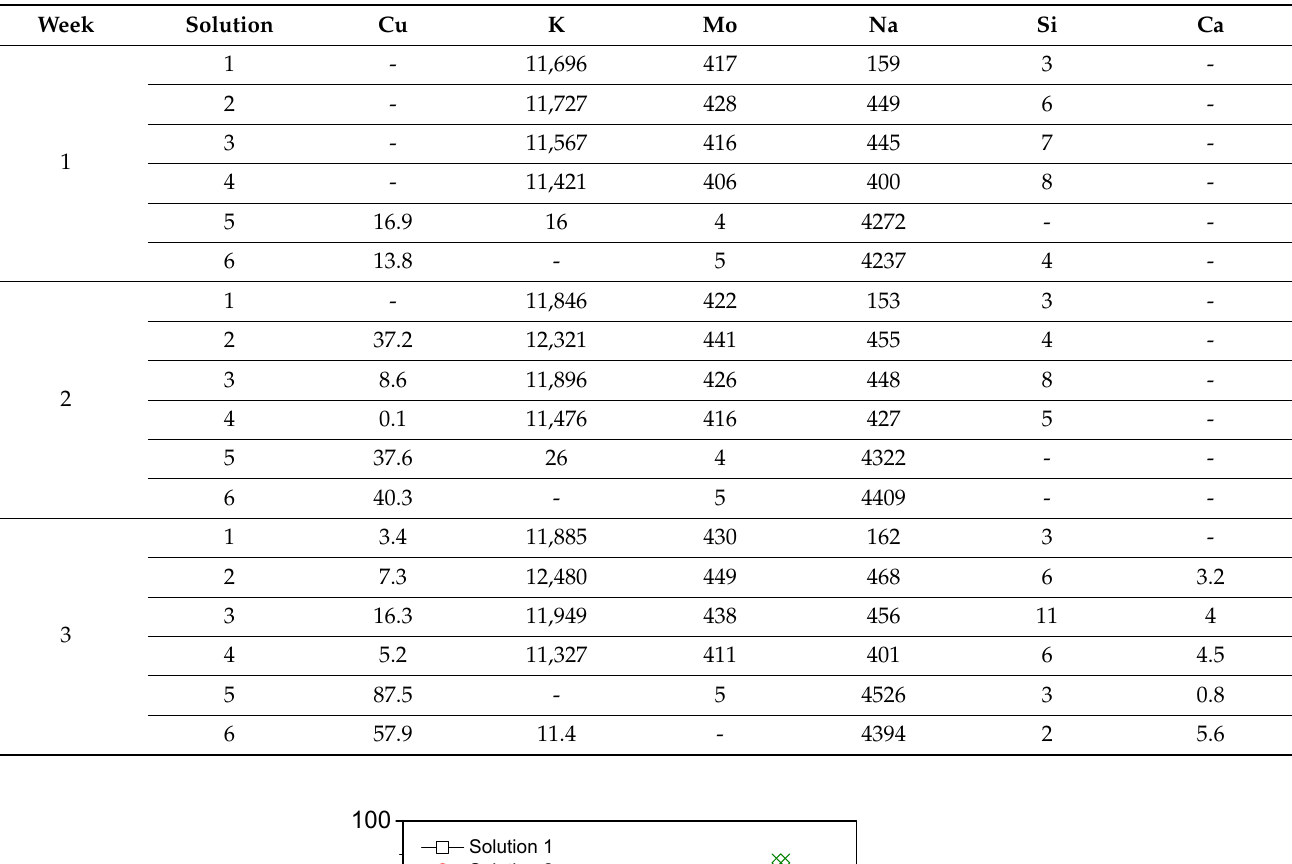
Table 3. The concentration of inorganic elements in the antifreeze solution after Cu immersion, measured by ICP-OES.